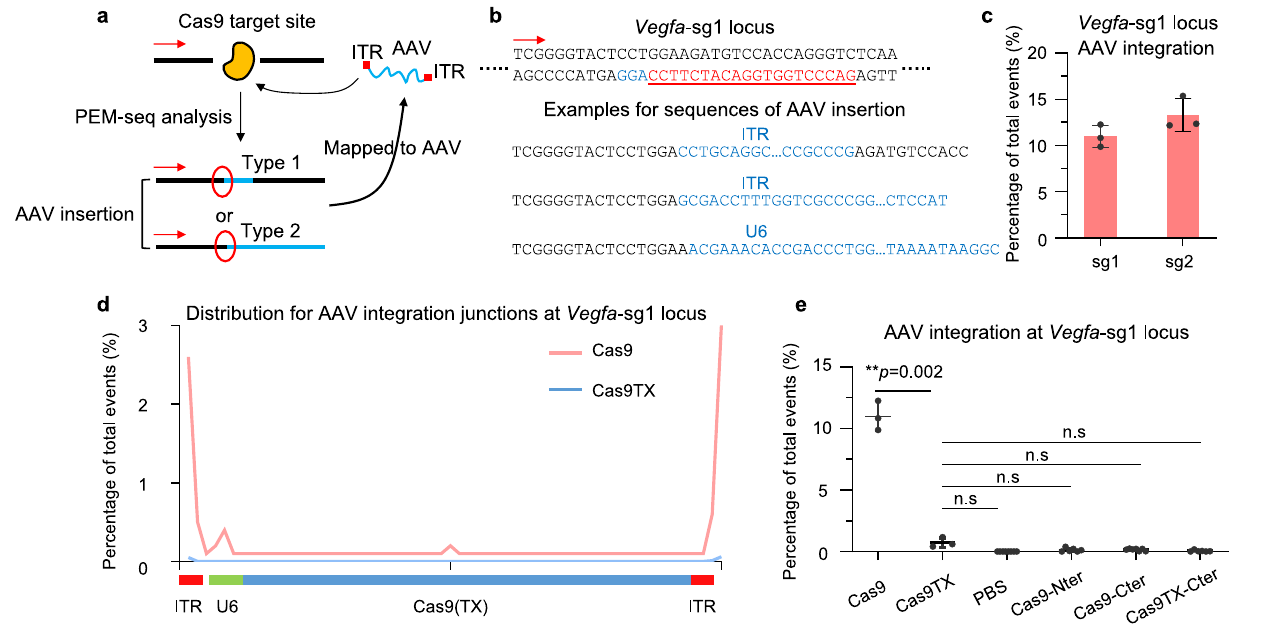
Fig. 4 | Cas9TX reduces AAV integrations to the background levels in vivo. a Schematics for the identi fi cation for AAV integrations by PEM-seq. Red arrows indicatetheprimersplacedonthe Vegfa locusinthegenome.AAVjunctionscanbe divided into two types as indicated. b Examples of DNA sequences for AAV inte- grations at Vegfa-sg1 . The blue letters indicate the integrated AAV sequence. c Frequency for AAV integrations at Vegfa -sg1 and Vegfa -sg2 normalized to total